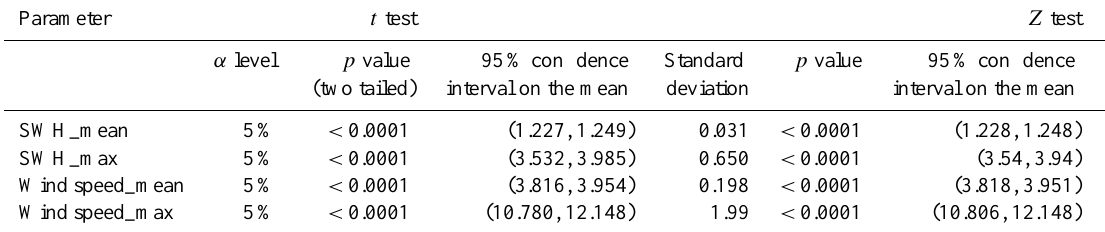
Figure 10. Temporal variation of (a) annual maximum wind speed and (b) annual maximum SWH from 1979 to 2010. Figure 10.Temporal variation of a) annual maximum wind speed b) annual maximum SWH and 477 during 1979-2010 478 Table 3. Student t test and Z test for wave and wind.